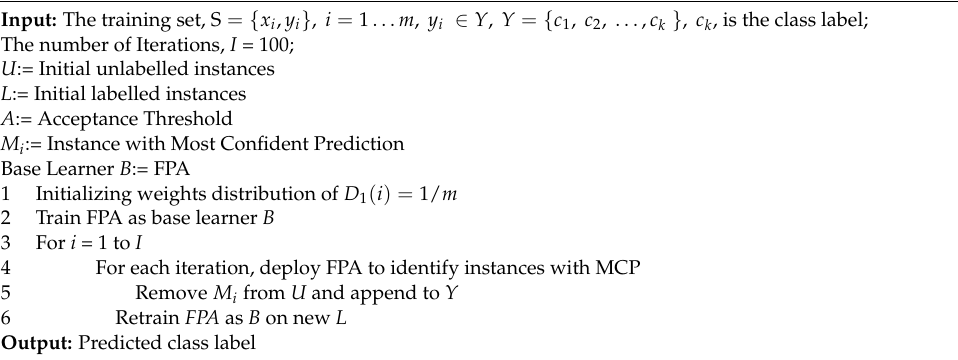
Algorithm 1: Cascade Generalization based Forest Penalizing Attributes (Cas_FPA).